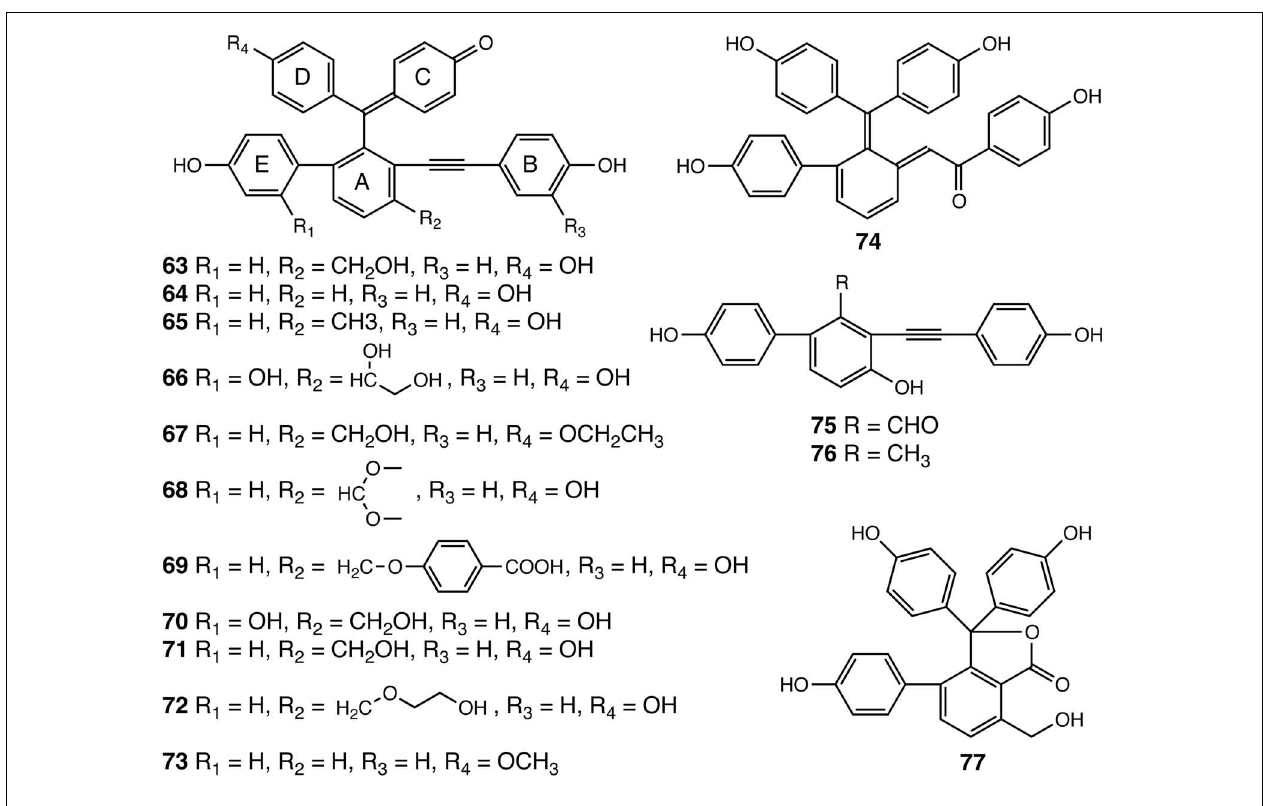
FIGURE 5 | Selaginellins identified from Selaginella . Selaginellin ( 63 ), Selaginellin A ( 64 ), Selaginellin B ( 65 ), Selaginellin C ( 66 ), Selaginellin D ( 67 ), Selaginellin E ( 68 ), Selaginellin F ( 69 ), Selaginellin I ( 70 ), Selaginellin J ( 71 ), Selaginellin M ( 72 ), Selaginellin N ( 73 ), Selaginellin G ( 74 ), Selaginellin K ( 75 ), Selaginellin L ( 76 ), Selaginellin H ( 77